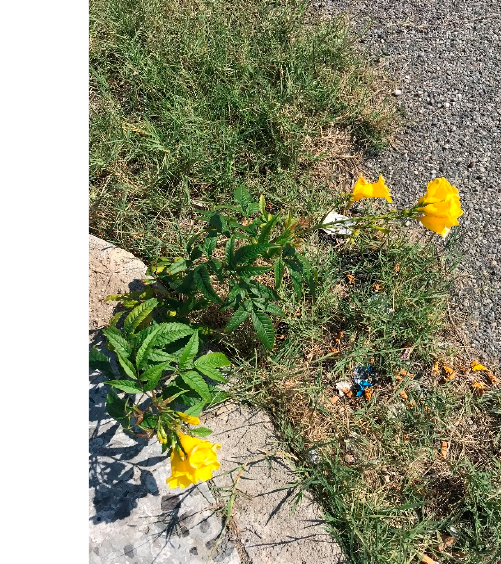
the left, inflorescences of S. punicea of the new location of Lamezia Terme (Photographs CM Musarella). Plants 2020 , 8 , x FOR PEER REVIEW